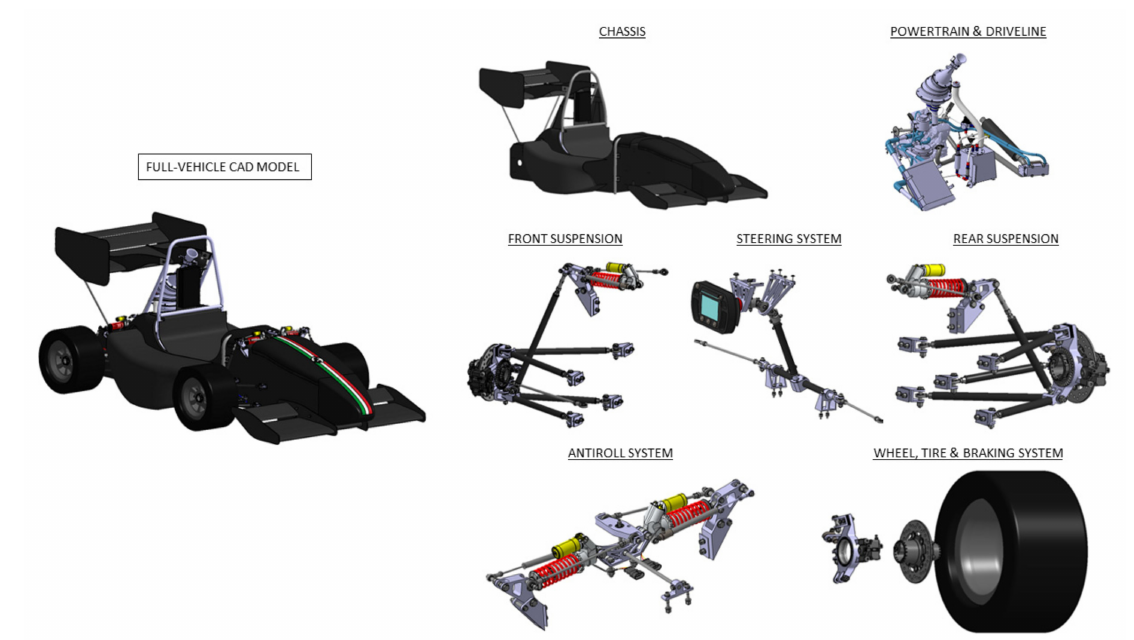
Figure 1. Subsystem integration leading to a full vehicle model—original CAD design.